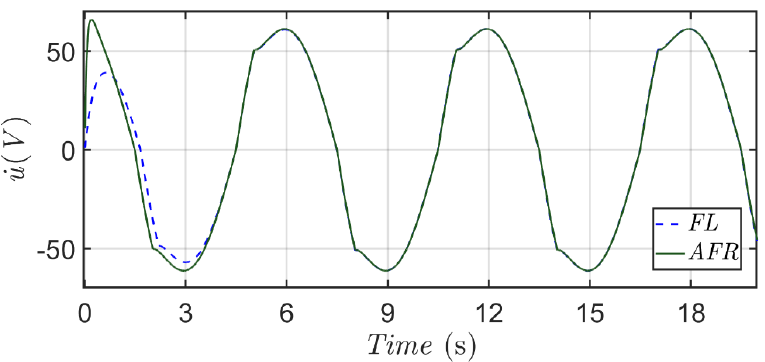
Figure 11. Histories of the overall control commands of the proposed method and feedback lineari- zation method.